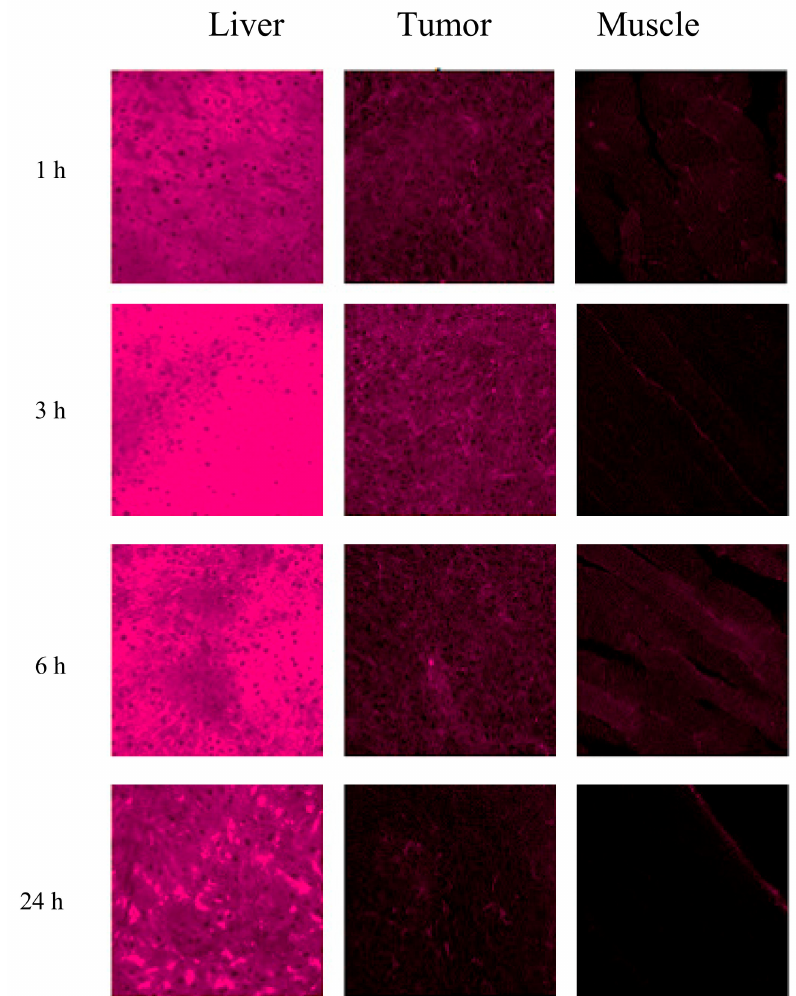
Figure 3. Fluorescent images of animal’s tissue samples in 1, 3, 6, and 24 h after the CCDC injection at a dose of 10 mg/kg. λ ex = 514 nm. λ em = 648–687 nm. Image size is 354 × 354 µ